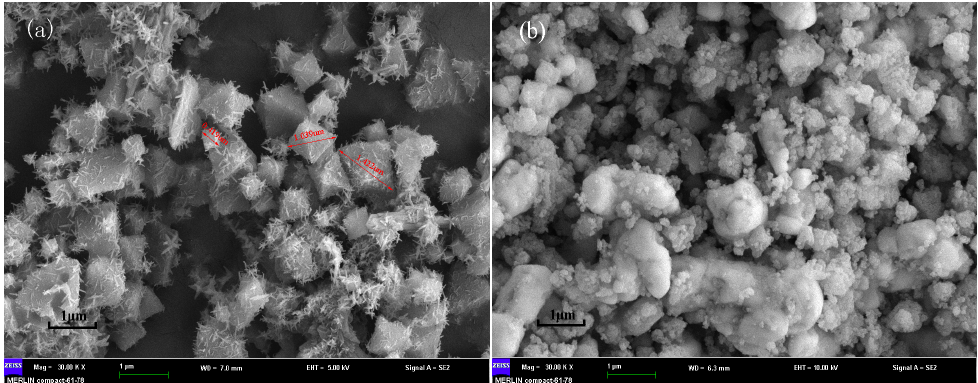
Figure 3. FTIR spectra of pure Ag/AgCl, MIL ‐ 101(Fe) and Ag/AgCl/MIL ‐ 101(Fe).